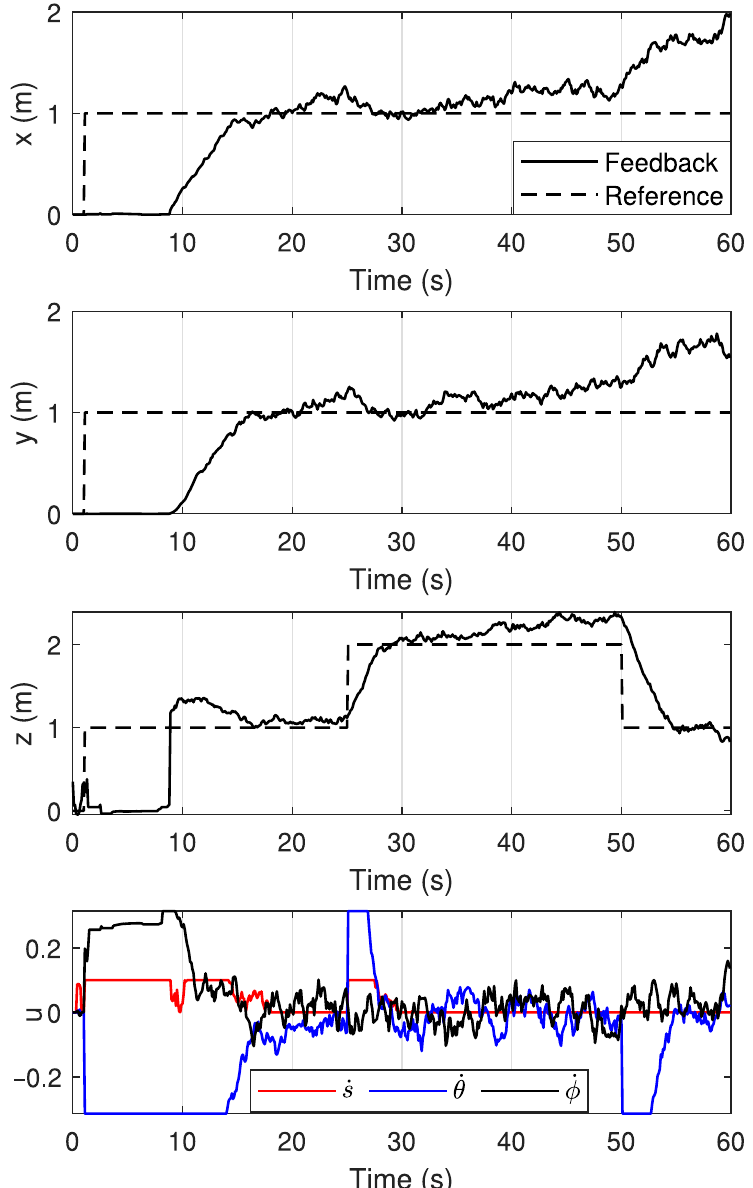
Figure 5. Results of point stabilization simulation experiment to assess the the proposed NMPC-based growth